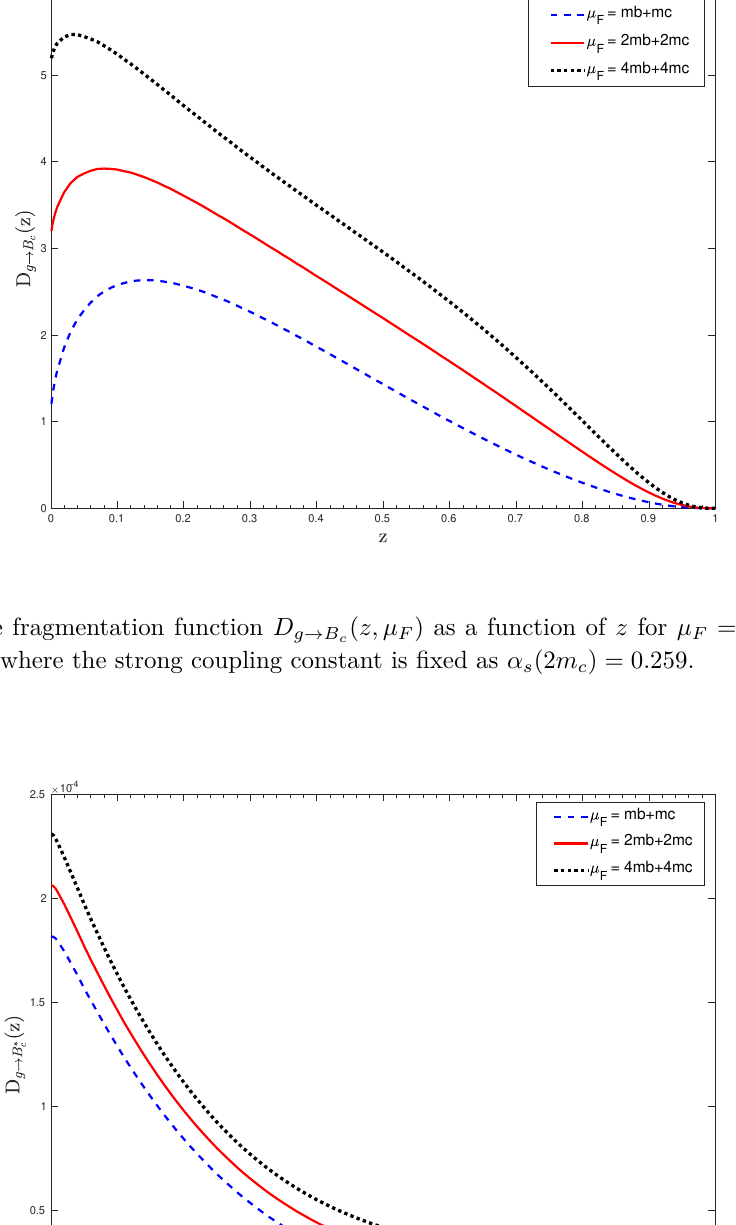
( z, µ F ) as a function of z for µ F = M , µ F = 2 M , c